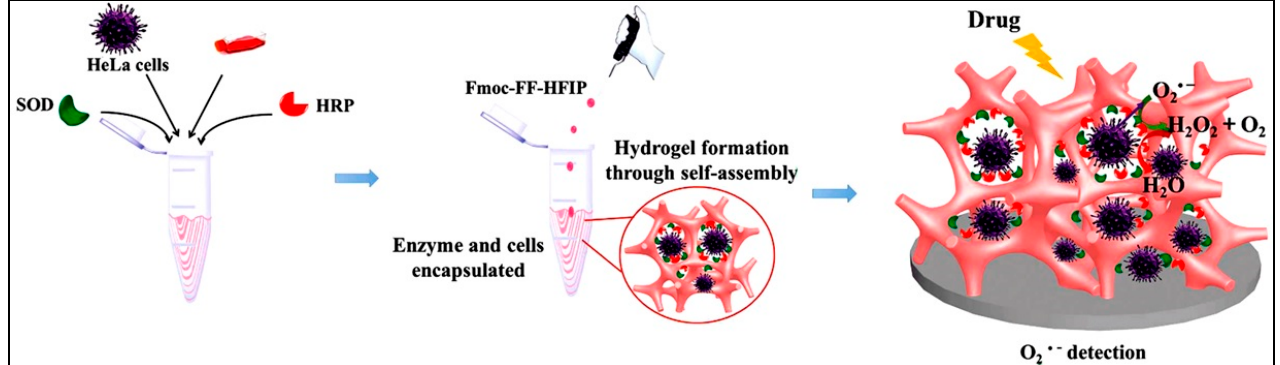
Figure 8. Schematic illustration of constructing a 3D cell culture-based electrochemical platform and its cell-monitoring assay. Reprinted with permission from Ref. [218], Copyright 2017, American Chemical Society.